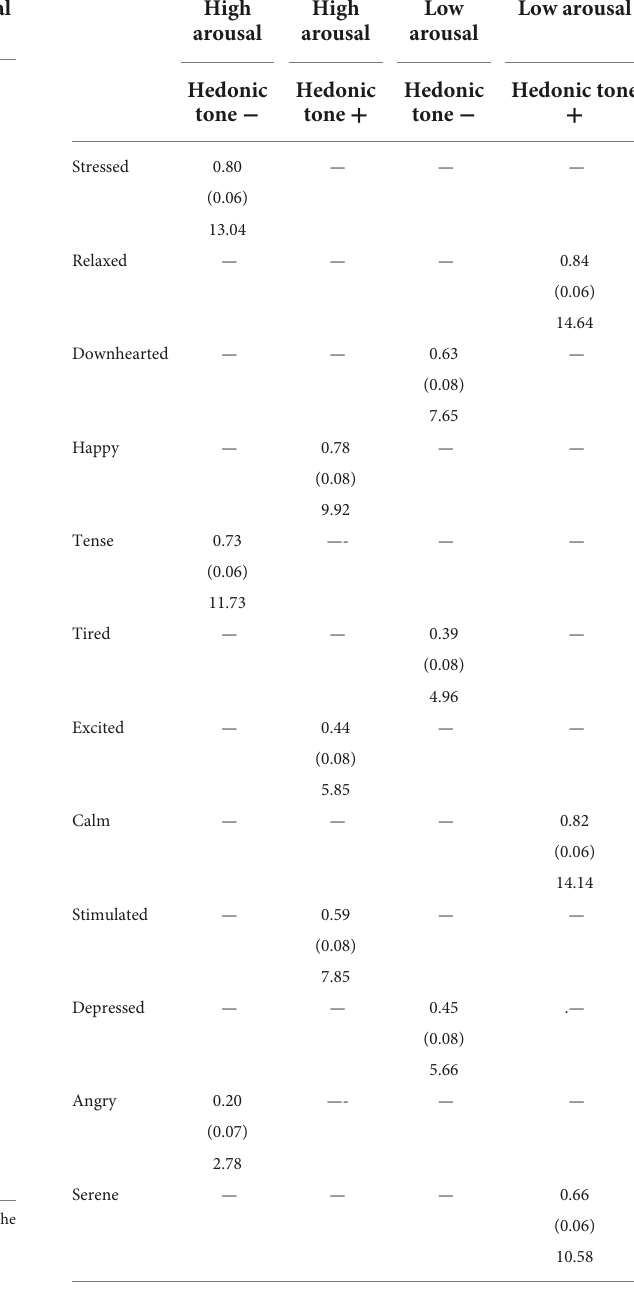
TABLE 2 Lambda-X matrix of the factor loadings for the four-factor model of the attentional style predictors.